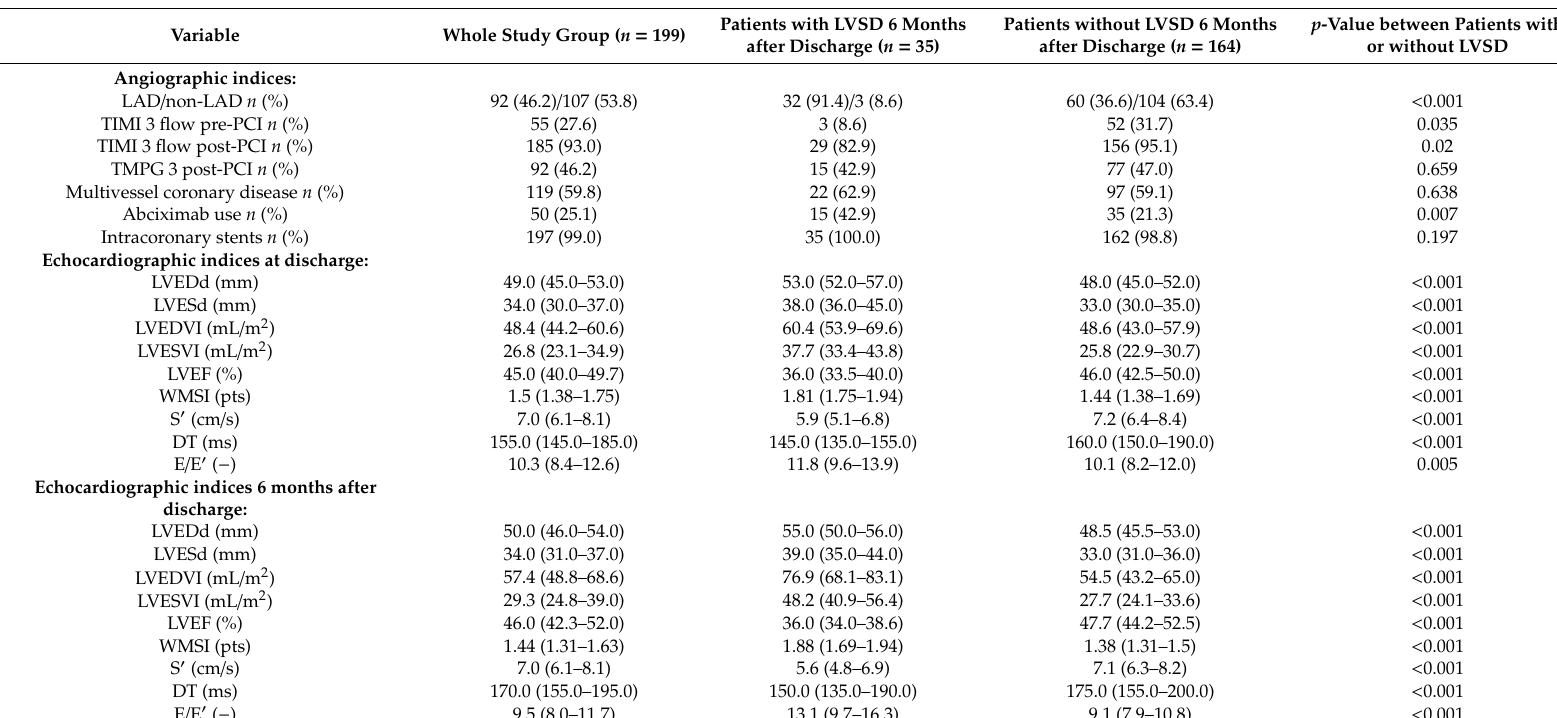
Table 2. Angiographic and echocardiographic characteristics of the whole study group of patients with ST-segment elevation myocardial infarction and two patient subgroups, which were found with or without left ventricular systolic dysfunction 6 months after